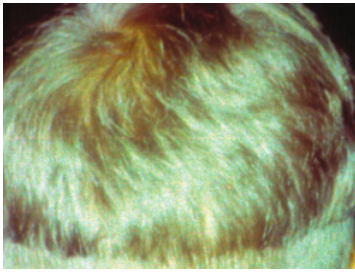
Figure 2 - GPS: silvery hair (case